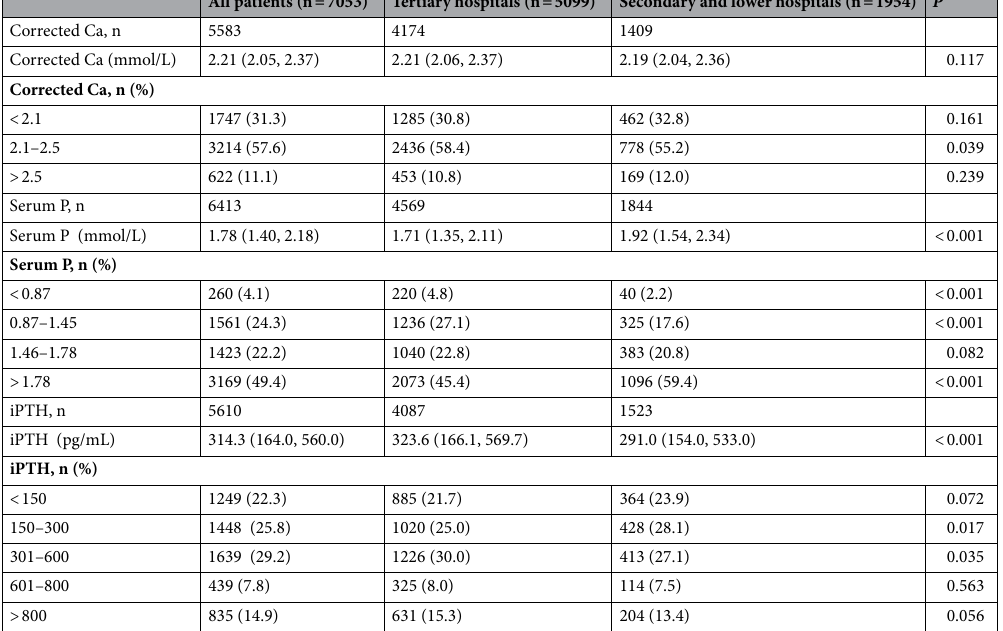
Table 3. The levels of Ca, P, and iPTH in different hospital